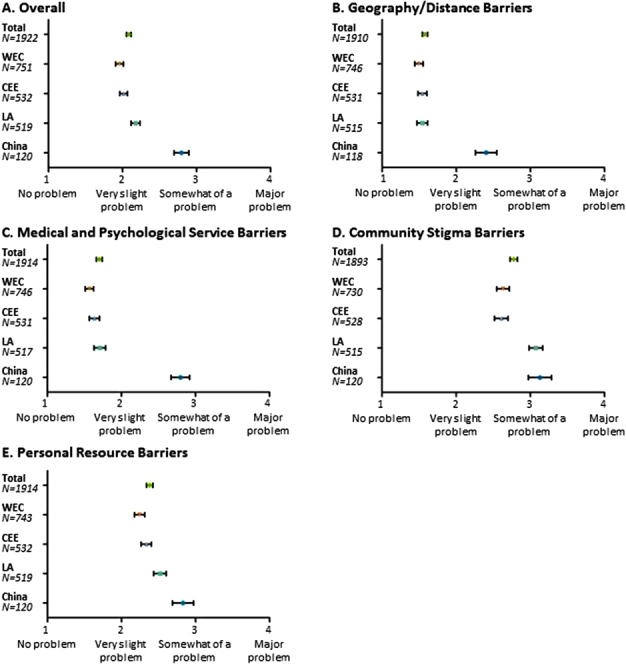
BACS severity scores. The position of the circle indicates the mean BACS severity score; the bars are 95% confidence intervals. Scores ≥2 were considered significant. The geography/distance subscale comprises BACS items 1 and 4. The medical and psychological service barriers subscale comprises BACS items 2, 3, 5, and 6. The community stigma barriers subscale comprises BACS items 7 and 8. The personal resource barriers subscale comprises BACS items 9, 10, 11, and 12.